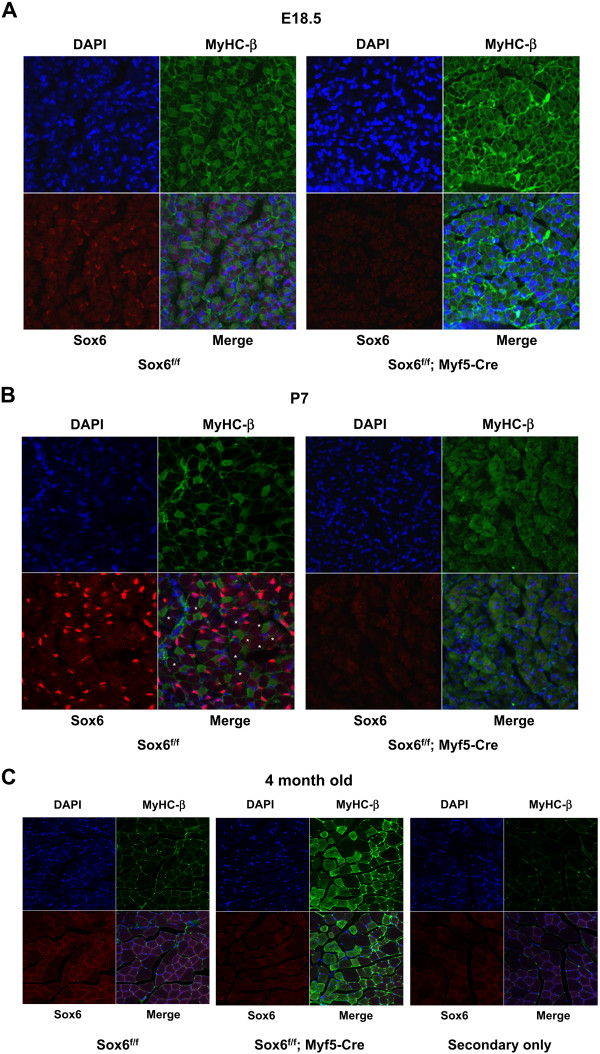
The number of fibers expressing MyHC-β is dramatically increased in Sox6 KO skeletal muscle. A. Cross-sections of E18.5 lower hindlimb muscle (TA-EDL region) from control (Sox6f/f) and Sox6KO (Sox6f/f; Myf5-Cre) were stained with DAPI (blue) or specific antibodies for MyHC-β (green) or Sox6 (red). x400 magnification. B. P7 (7 day old) hindlimb muscle processed for DAPI, Sox6 and MyHC-β immune-staining.* indicates myotubes that are negative for both MyHC-β and Sox6 staining in control muscle (see text for discussion). x400 magnification. C. Four month old adult TA-EDL muscle. A control muscle section stained with DAPI or secondary antibodies (a mixture of both anti-mouse and anti-rabbit) only was also shown. ×200 magnification.